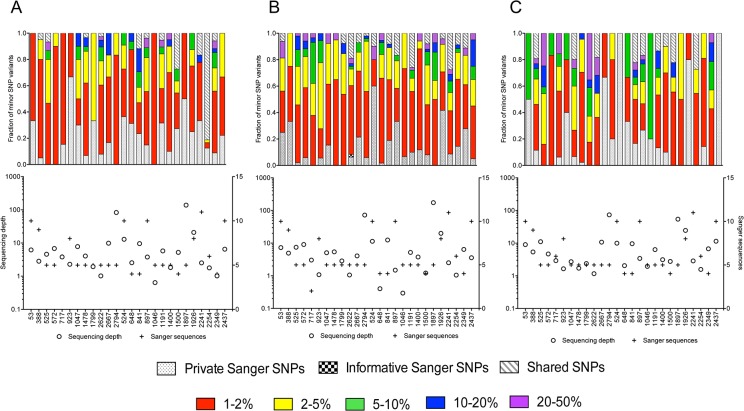
Frequencies of minor SNPs.Minor SNPs (frequencies between 1–50%) were compared in the 26 subjects with a single founder virus across gag (A), gp120 (B) and nef (C). The upper panels indicate for each subject the proportion of minor SNP variants in each category. The categories included shared (found in both Sanger and pyrosequences), Sanger-specific, including those that were Private (found in 1 sequence) and Informative (found in 2+ sequences), or found only in pyrosequences (with frequencies indicated by color: 1–2%, red; 2–5%, yellow; 5–10%, green; 10–20%, blue; 20–50%, purple). The lower panels show the pyrosequencing depth (o, left y-axis), defined as number of reads mapped to a position divided by mean number of amplifiable viral templates, and the number of Sanger sequences (+, right y-axis). The X-axis lists the subject publication ID (502-XXXX)[51]. Comparable data for subjects replicating multiple founder viruses is shown in S4 Fig.